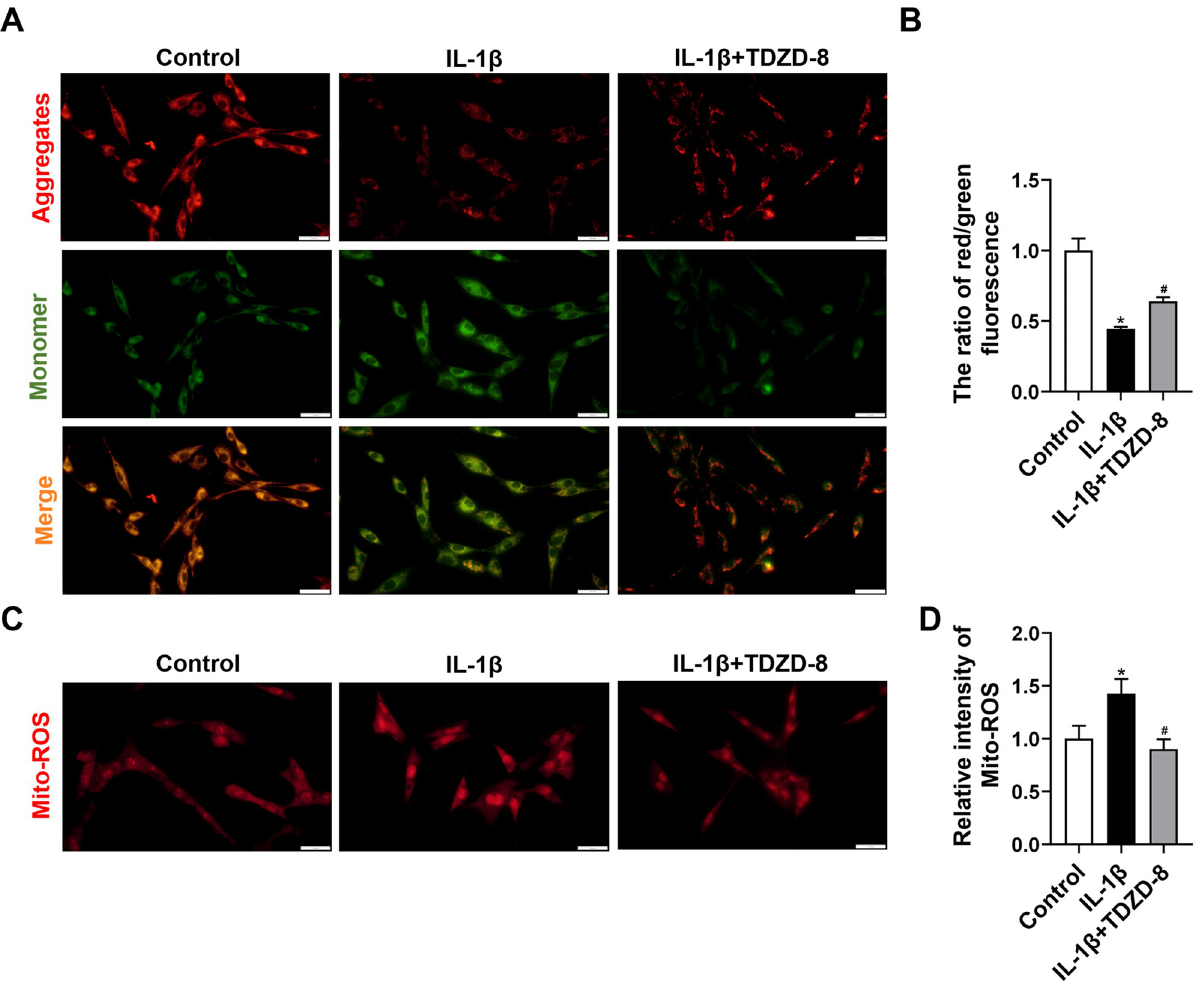
Fig 5. Effect of TDZD-8 on mitochondrial function in IL-1 β -induced C6 cells. (A) Detection of the mitochondrial membrane potential in control, IL-1 β , and IL-1 β + TDZD-8 groups by labeling with the JC-1. Scale bar = 20 μ m. (C) Detection of mitochondrial ROS by labeling with the MitoSOX. Scale bar = 20 μ m. (B, D) Quantitative fluorescence intensity of JC-1 (C) and Mito-ROS (D). Data are expressed as the mean ± SD. * P < 0.05 vs . control group, # P < 0.05 vs . IL-1 β group.